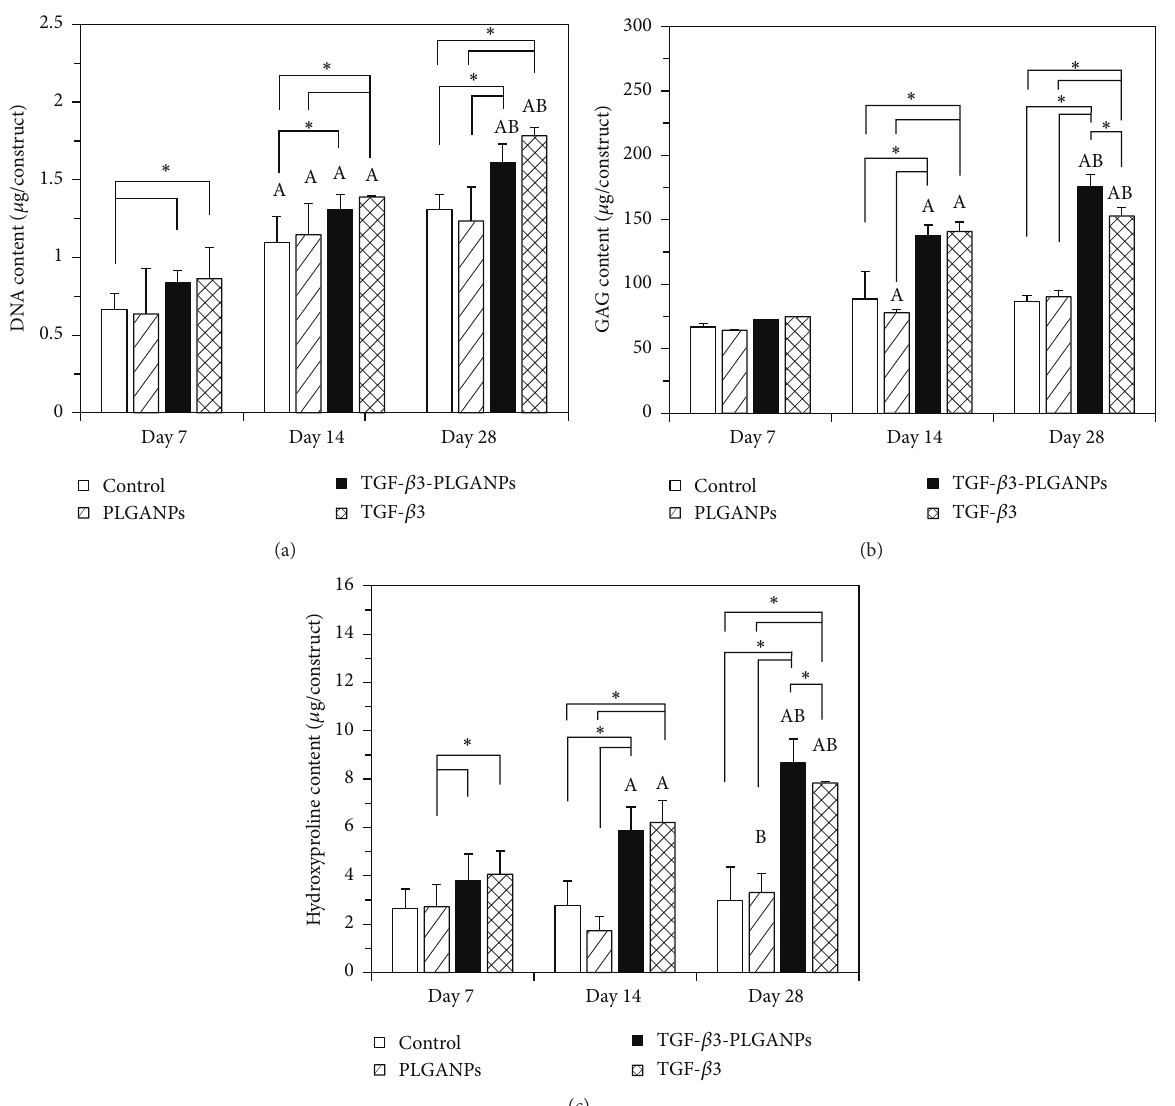
Figure 7: Measurement of the biochemical content of the hybrids including (a) DNA, (b) GAG, and (c) HYP of the MSCs-seeded dextran/gelatin hydrogels encapsulated with no supplement (control), 1000 𝜇 g/mL blank PLGANPs (PLGANPs), 1000 𝜇 g/mL TGF- 𝛽 3-loaded PLGANPs (TGF- 𝛽 3-PLGANPs), and the hydrogels with no supplements cultured in the medium containing 10ng/mL TGF- 𝛽 3 (TGF- 𝛽 3) for 7, 14, and 28 days. Data were expressed as means ± SD ( 𝑛 = 3 ). The samples indicated with ( ∗ ) had a significant difference between the two groups ( 𝑝 < 0.05 ). The samples indicated with (A) had a significant difference compared to the same group on day 7 ( 𝑝 < 0.05 ) and (B) had a significant difference compared to the same group on day 14 ( 𝑝 < 0.05